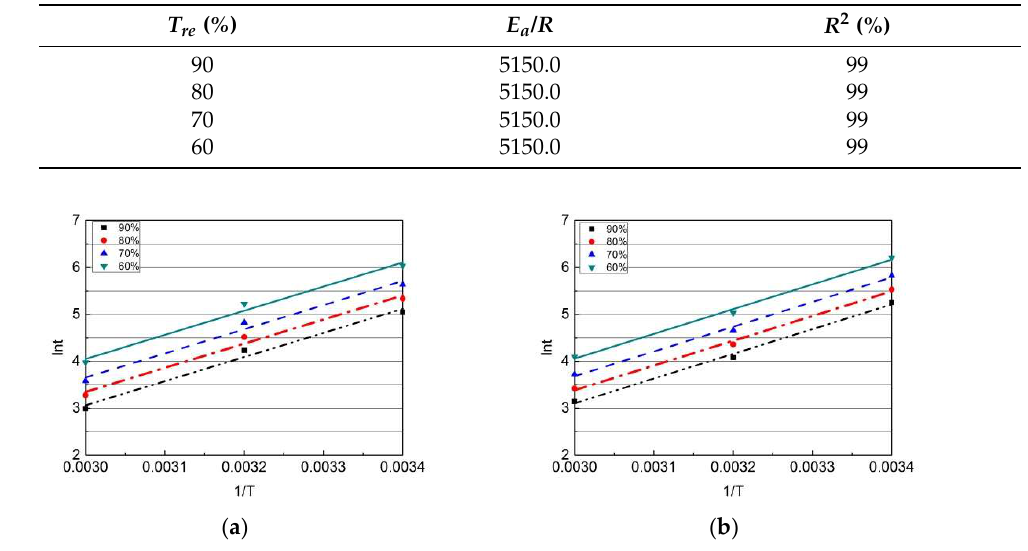
Table 19. 𝑅 (cid:2870) values of the second, third, and fourth models for the estimated data and test data at 20 °C.